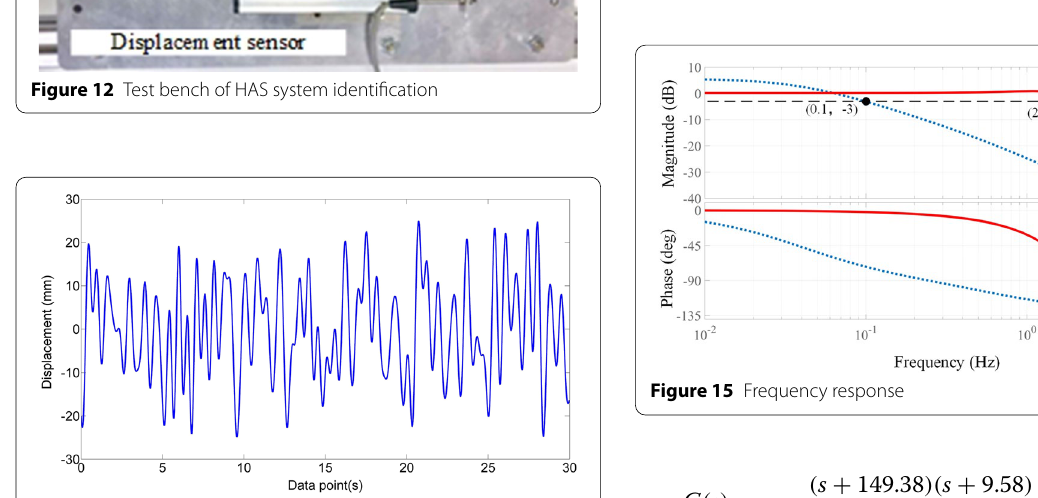
Figure 13 Sine input of the system identification